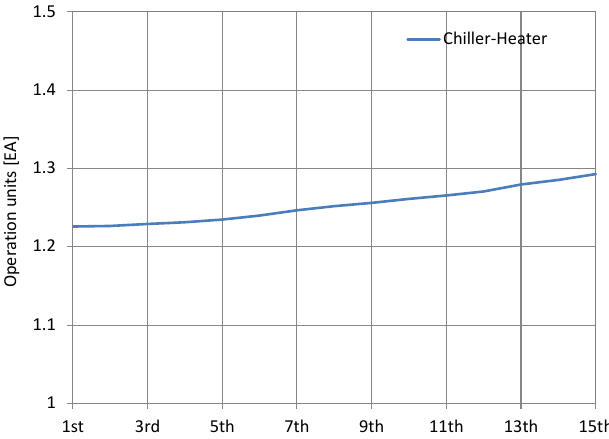
Figure 10. Changes in the annual average number of heat source equipment.